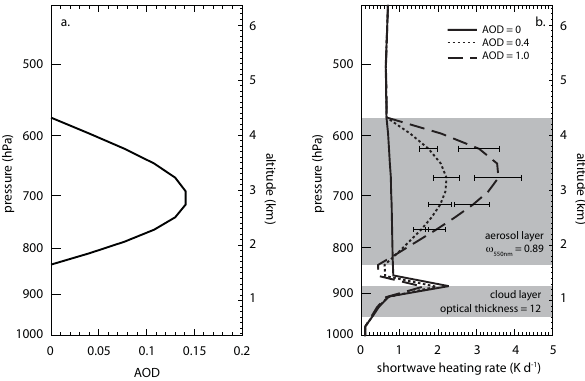
Fig. 2. (a) The vertical profile of aerosol optical depth (AOD) in each 24hPa layer of the radiative transfer model for the case with total column optical depth of 1.0. (b) Simulated atmospheric short- wave heating rates for smoke layers of AOD=0, 0.4, and 1.0 above a stratocumumlus cloud layer of optical thickness 12 and aerosol single-scattering albedo at 550nm of 0.89. Horizontal bars indicate the range of heating rates for single-scattering albedo 0.89 ±